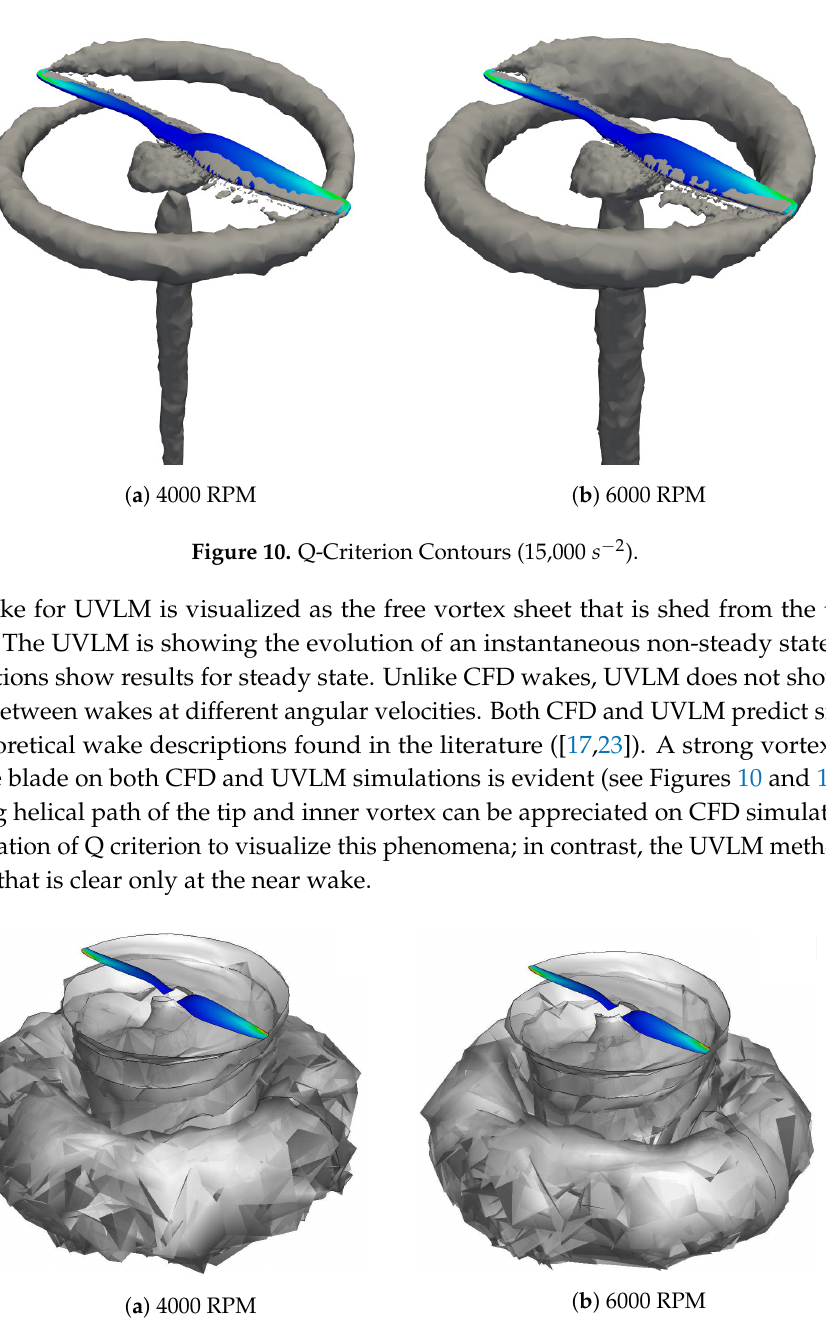
Figure 11. UVLM wake